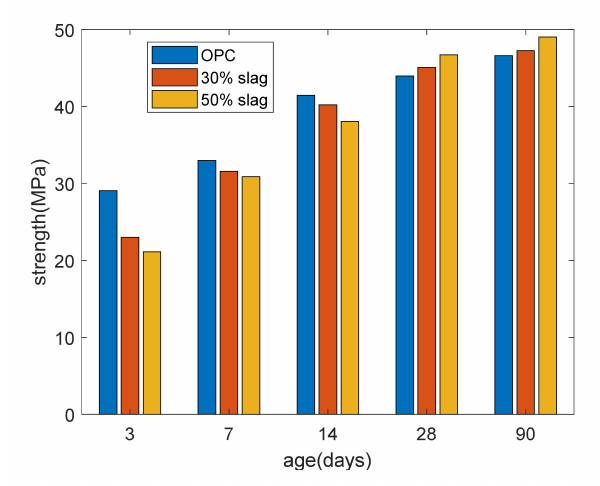
Figure 3. Strength of paste.